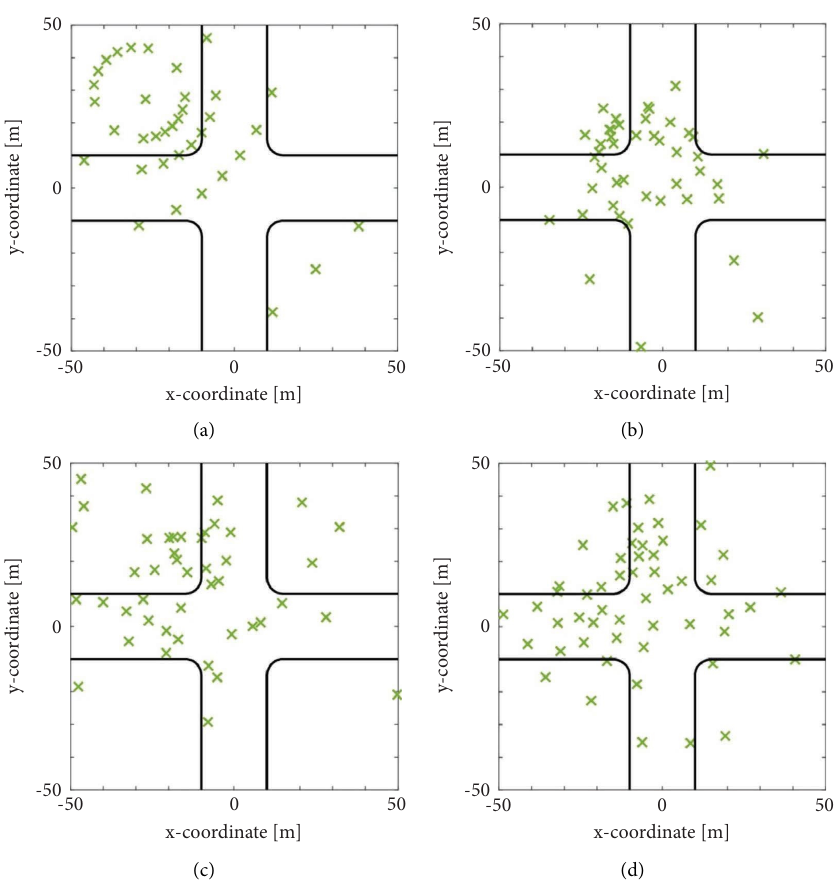
Figure 8: Beamforming directions of generated codevectors projected on the ground surface: (a) initial codebook, (b) after a single iteration, (c) after 10 iterations, and (d) after 100 iterations.